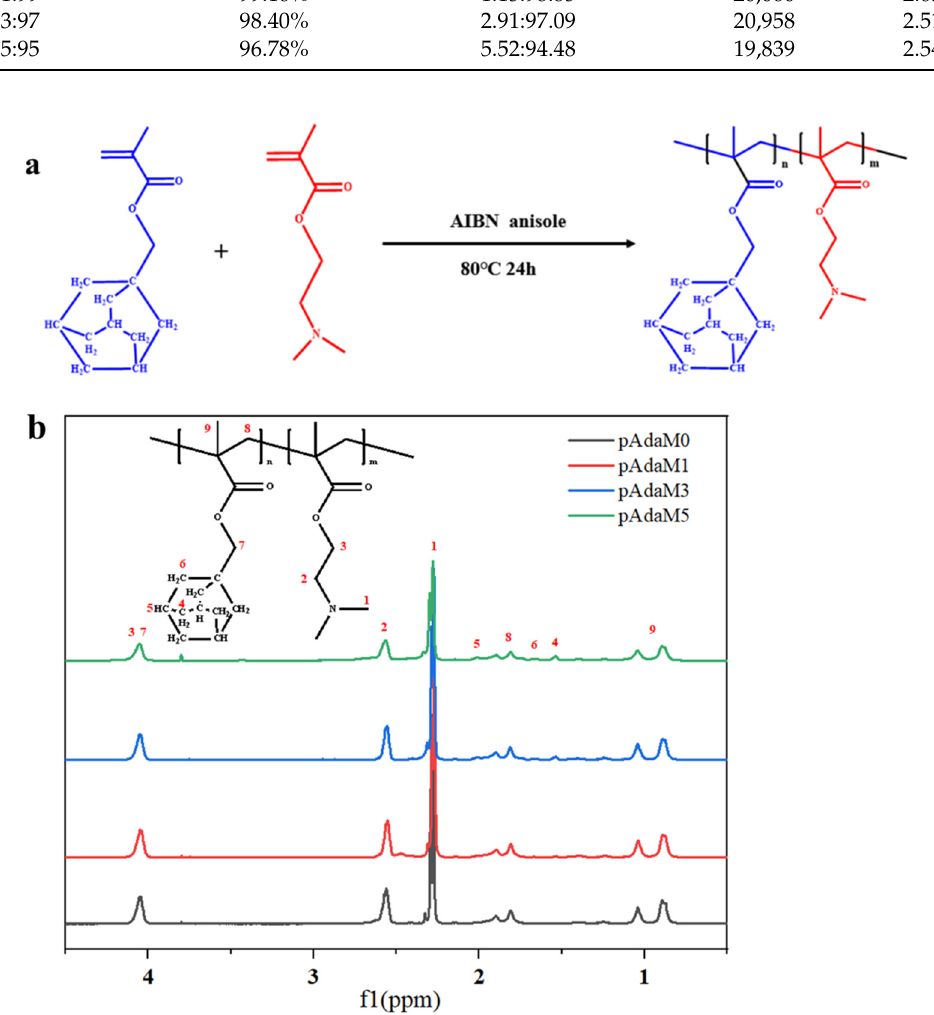
Figure 2. ( a ) The schematic illustration of the synthesis of PAdaMX; ( b ) 1 H-NMR spectra of PAdaMX (in